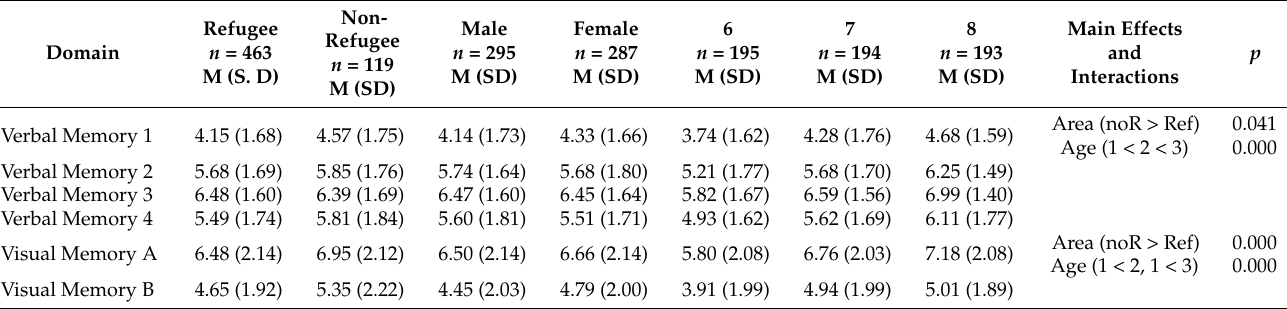
Table 4. Verbal and visual memory tests